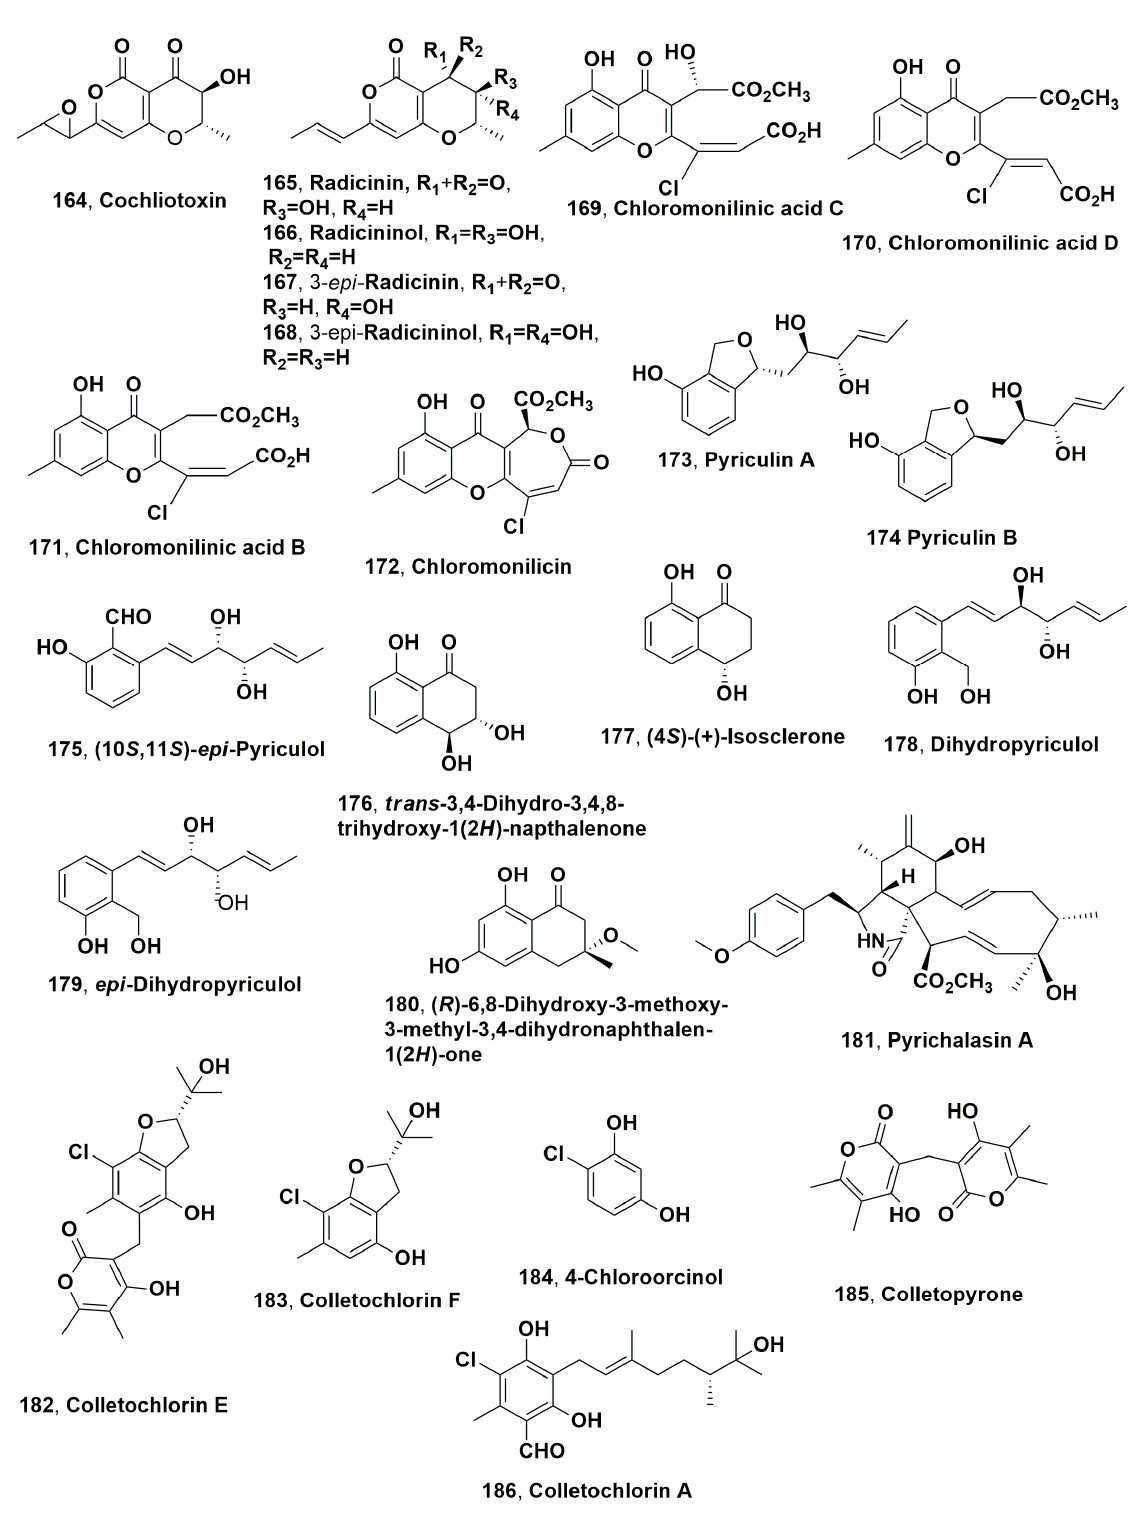
Figure 7. Metabolites produced by Cochliobolus australiensis ( 164 – 171 ), Ascochyta sonchi ( 172 ), Perycularia grisea ( 173 – 182 ) and Colletotrichum higginsianum ( 183 – 186 ). Pyriculins A and B ( 173 and 174 , Figure 7), two monosubstituted hex-4-ene-2,3-diols, were isolated together with (10 S ,11 S )-( − )- epi -pyriculol,